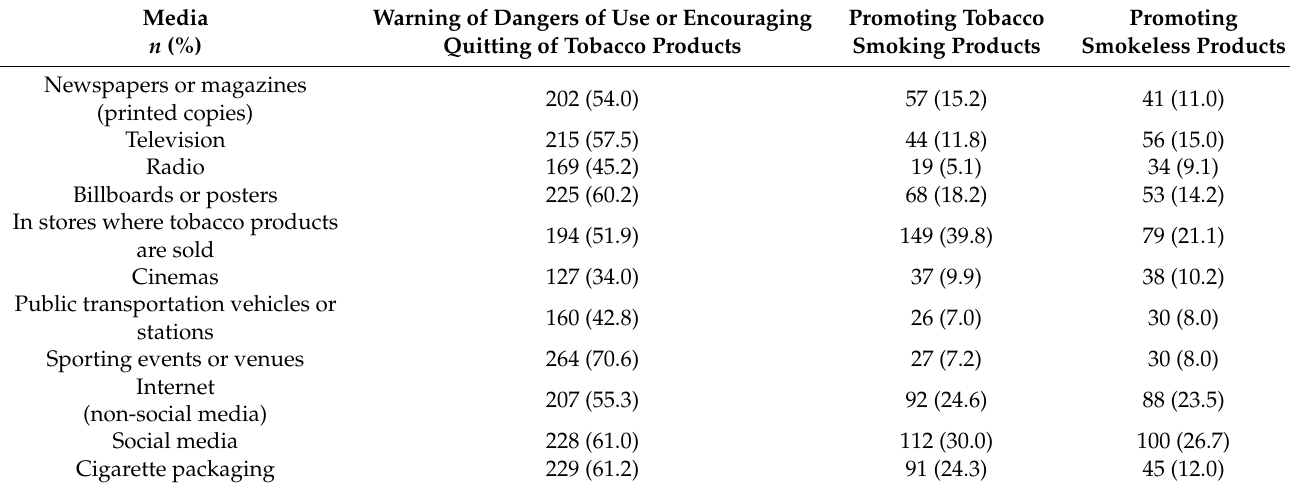
Table 3. Exposure to smoking in the media in the last 30 days ( n = 374) with multiple responses allowed.